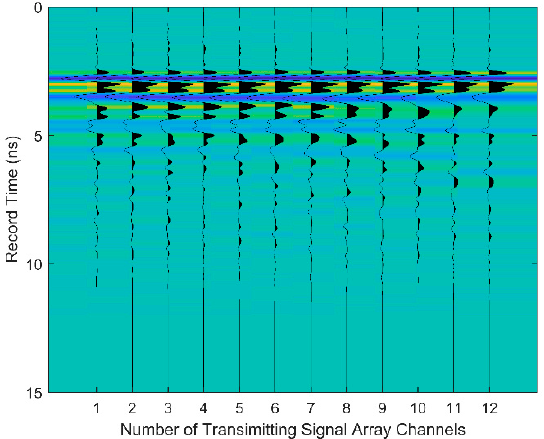
Figure 4. Waveforms of transmitting signals from 12 Vavaldi antennas on Chang’E-5. Table 1. The specific positions of Chang’E-5 Antennas.